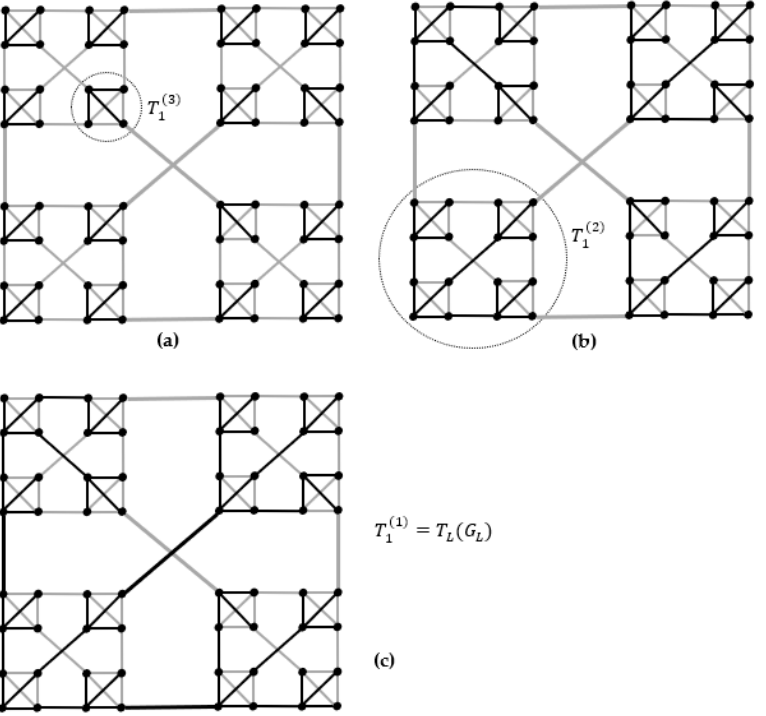
Figure 4. The spanning tree of the entire prefractal graph G 3 generated by a complete 4-vertex seed, the old edges of which are not adjacent.